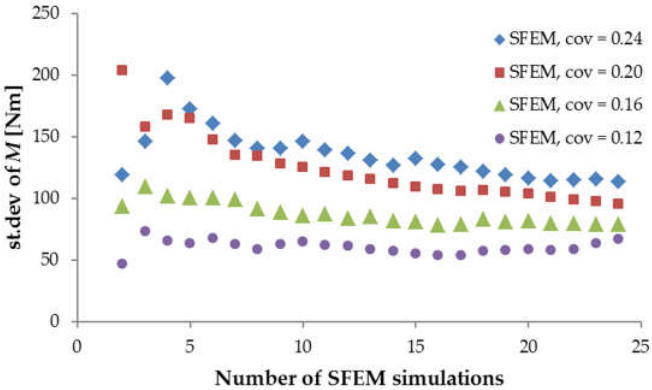
Figure 6. The calculated standard deviation of the ultimate bending moment M against the number of SFEM simulations for beam LM200.